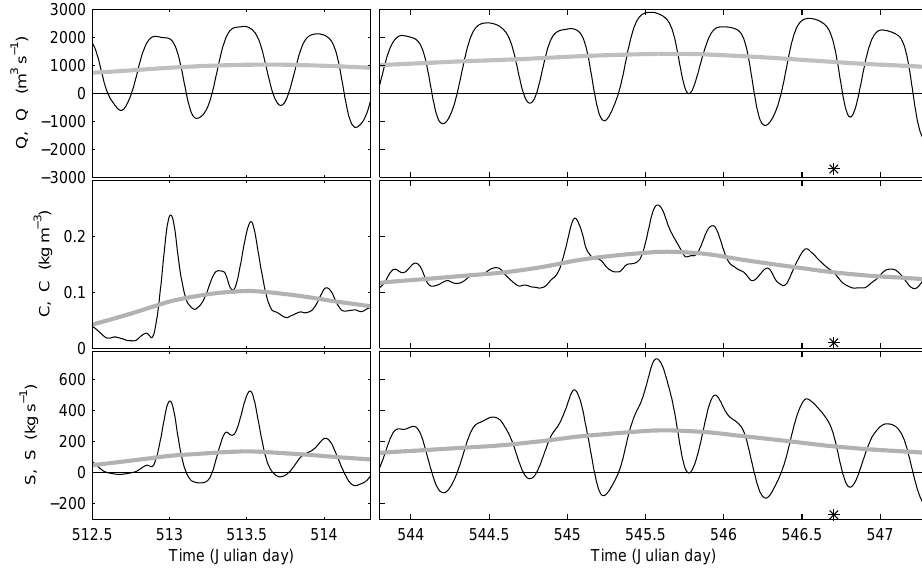
Fig. 11. As Fig. 8, now zoomed in on two periods with the highest observed tidally averaged suspended sediment load.